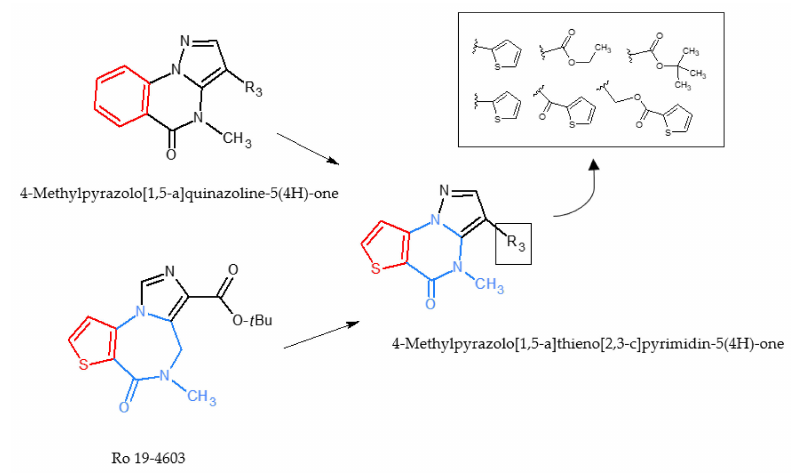
Figure 3. Aim of the